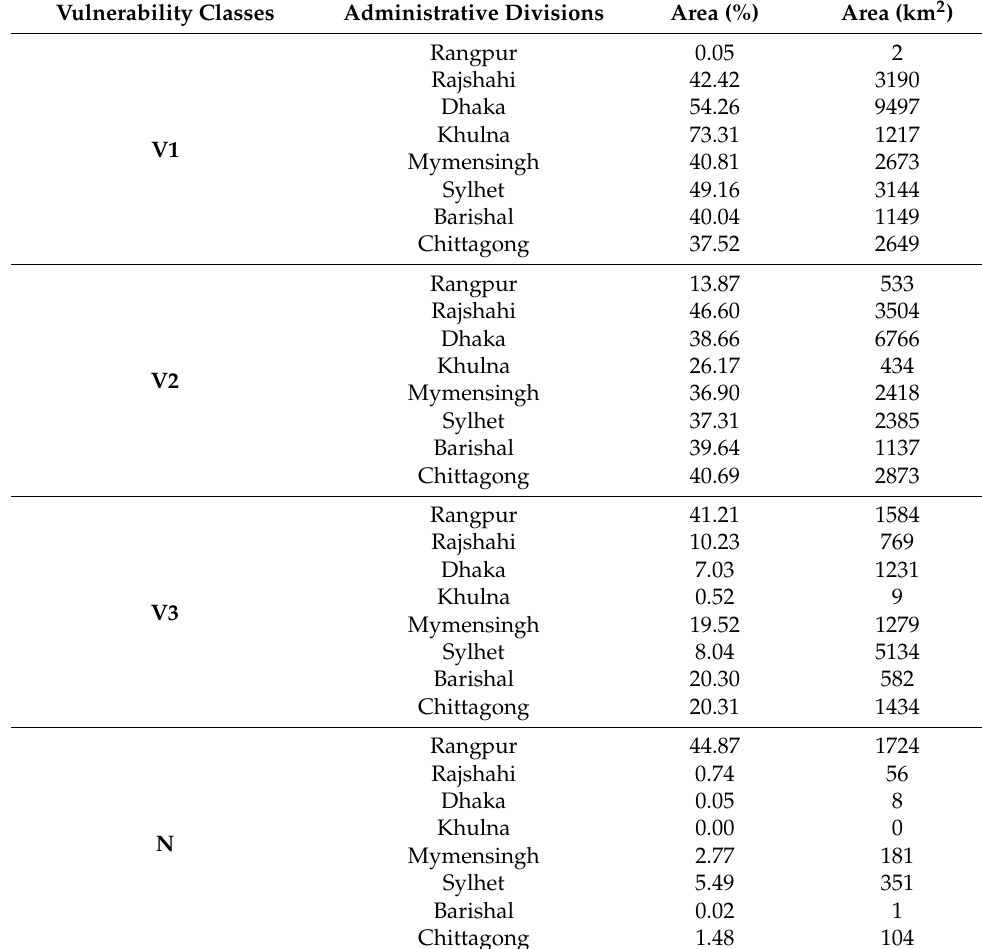
Table 5. Vulnerable areas for agricultural land use according to the vulnerability classes in eight administrative divisions in Bangladesh. (V 1 : highly vulnerable area, V 2 : moderately vulnerable area, V 3 : marginally vulnerable area, and N: nonvulnerable area for agricultural land